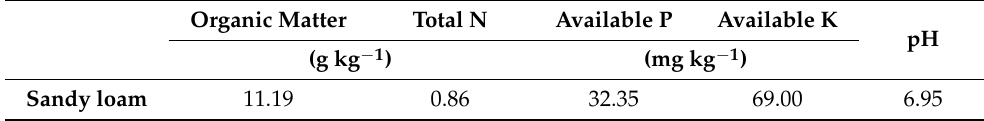
Table 1. Chemical properties of the experimental soil at the beginning of the experiment. Organic Matter Total N Available P Available K